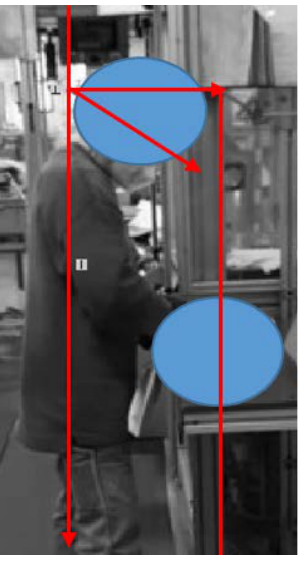
Figure 12. Critical flexion of the head in the Beta workstation.